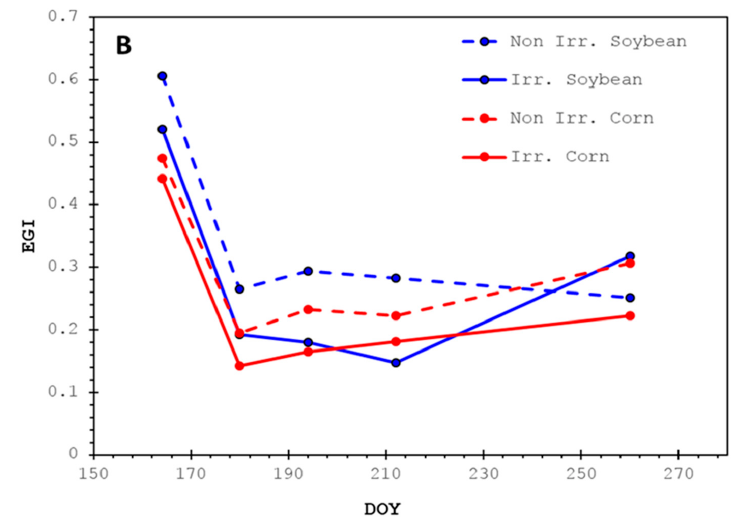
Figure 10. Seasonal profile of NGI ( A ) and EGI ( B ) for irrigated and non-irrigated soybean and corn during the 2014 growing season. Each data point is an average of nine contiguous pixels of a square. DOY denotes Day of Year.